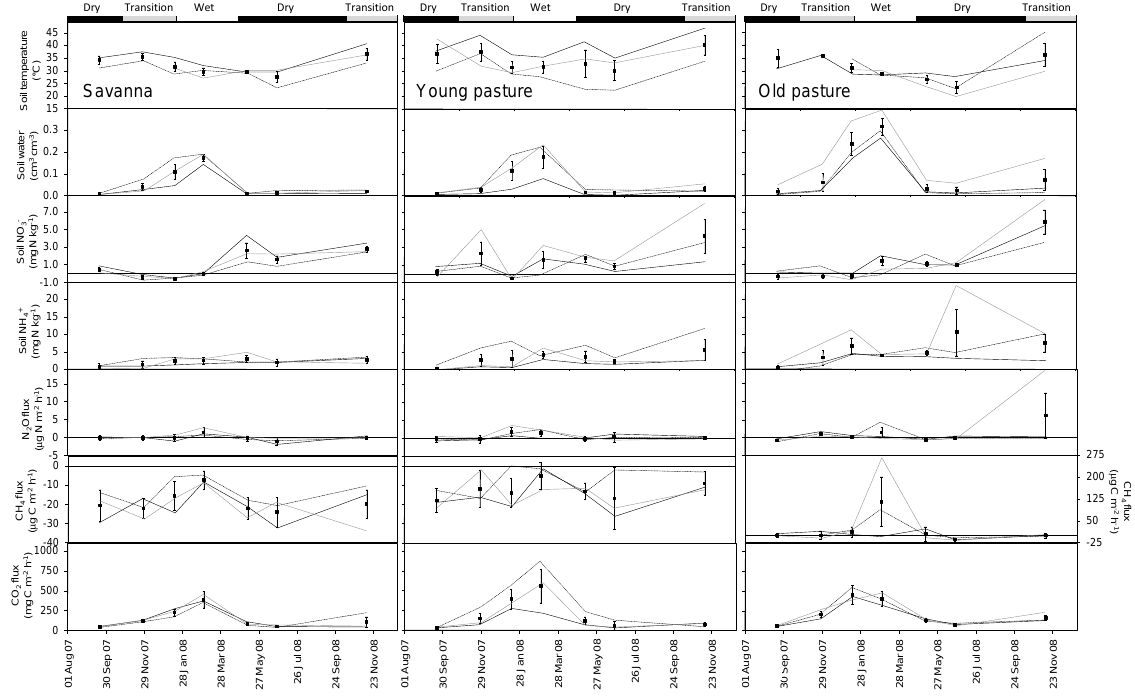
Fig. 2. Seasonal patterns of soil gas fluxes and environmental properties at savanna woodland, young pasture and old pasture sites as measured by static manual chambers on seven separate measurement events. Solid data points with standard error bars are the average of three replicate sites, as indicated by solid line, grey line and dashed line. Five measurements of flux and soil properties were made at each site.